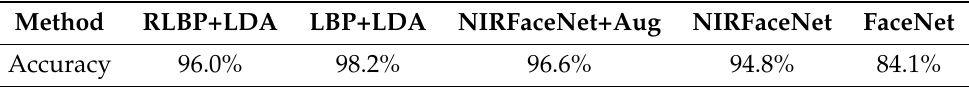
Table 6. Accuracy of our RLBP+LDA and LBP+LDA methods compared to other face classification algorithms discussed in [26], using the CBSR NIR [79]